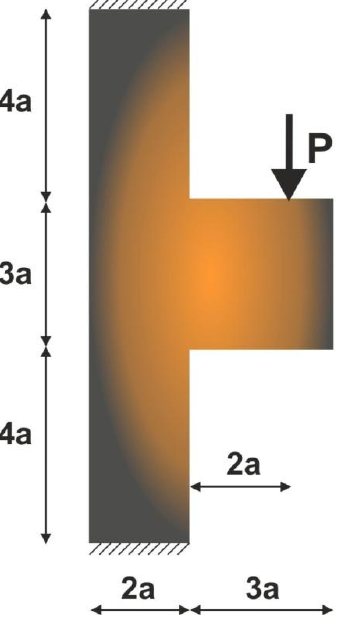
Figure 18. The test structure 4 with applied load and support.